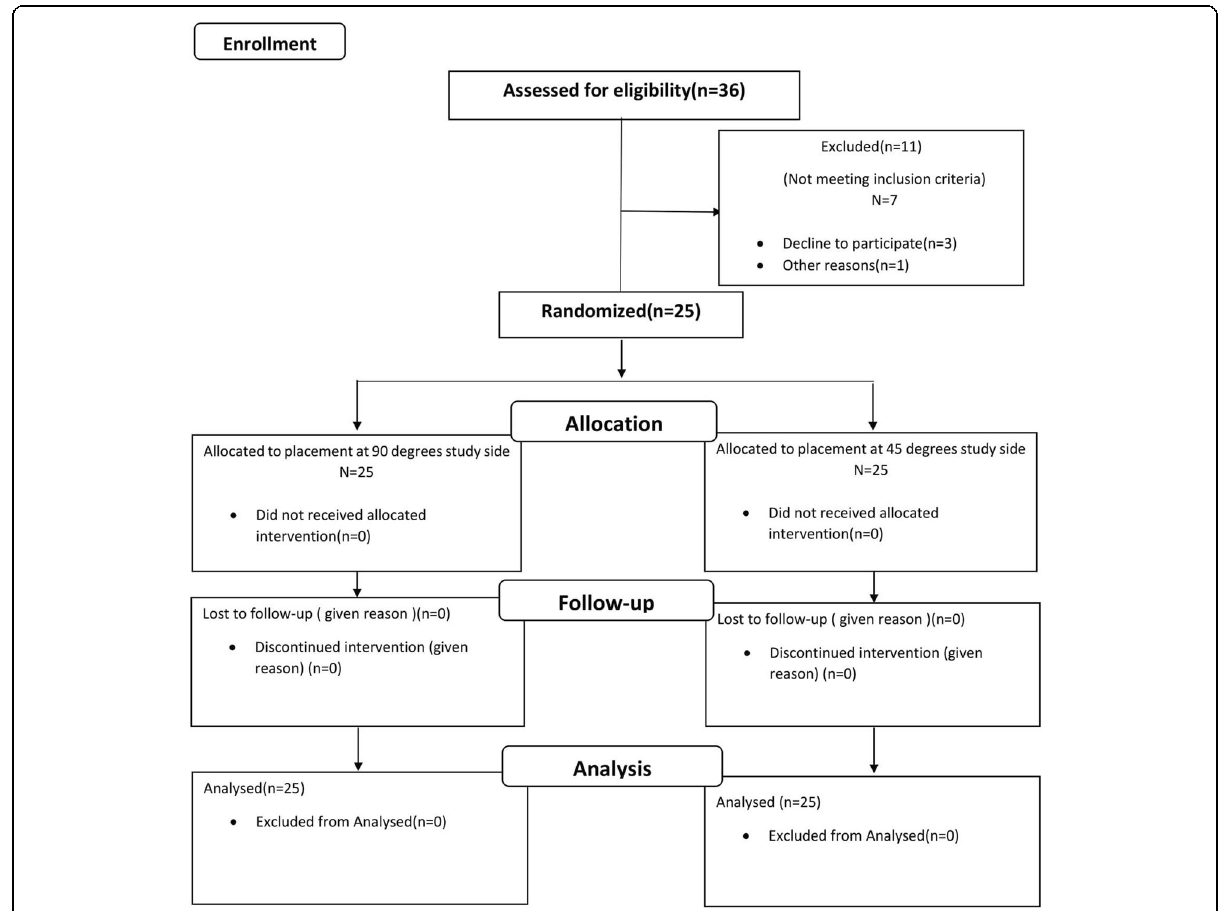
Fig. 4 Flow diagram of the study according to the Consolidated Standards of Reporting